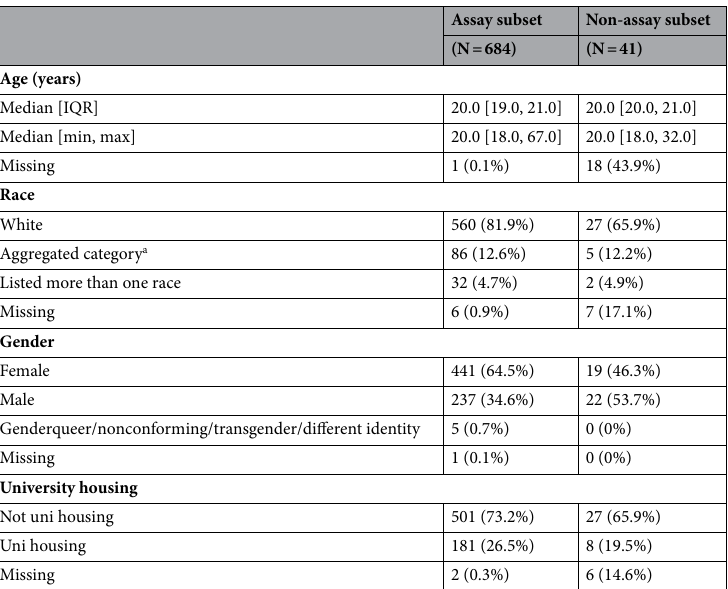
Table 2. Demographic characteristics of the returning student participants. a Asian; Hispanic, Lantino/a, or Spanish; Black or African American; Middle Eastern or North African; Native American or Alaska Native; other race or ethnicity. This category is aggregated to protect participant identities because no single group comprised > 4% of